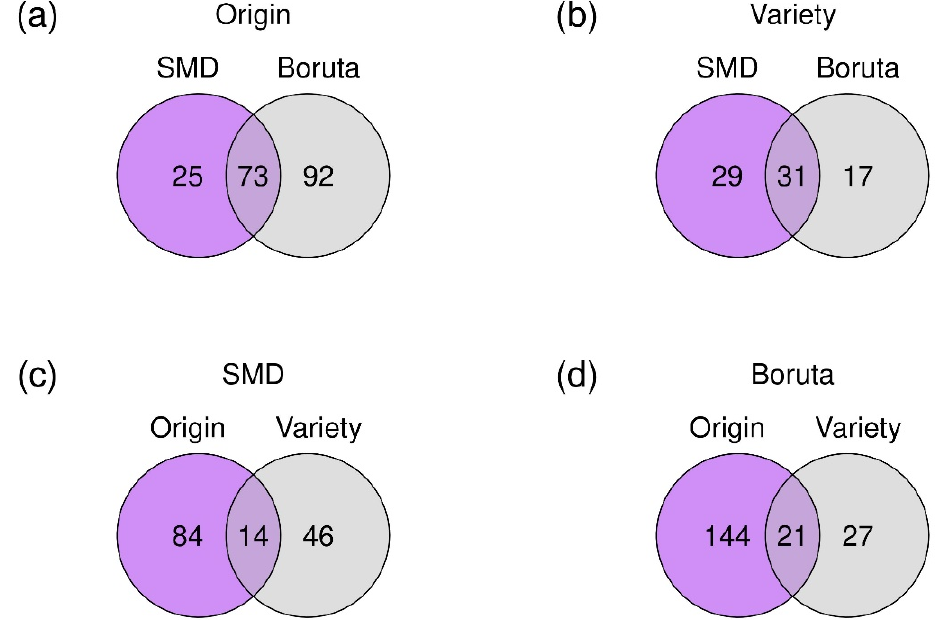
Figure 2. Venn diagrams of selected features for the classification on the different levels of geographical origin ( a ) and botanical variety ( b ) utilizing the approaches SMD ( c ) and Boruta ( d ). Detailed lists of the selected features can be found in Tables S3 and S4.